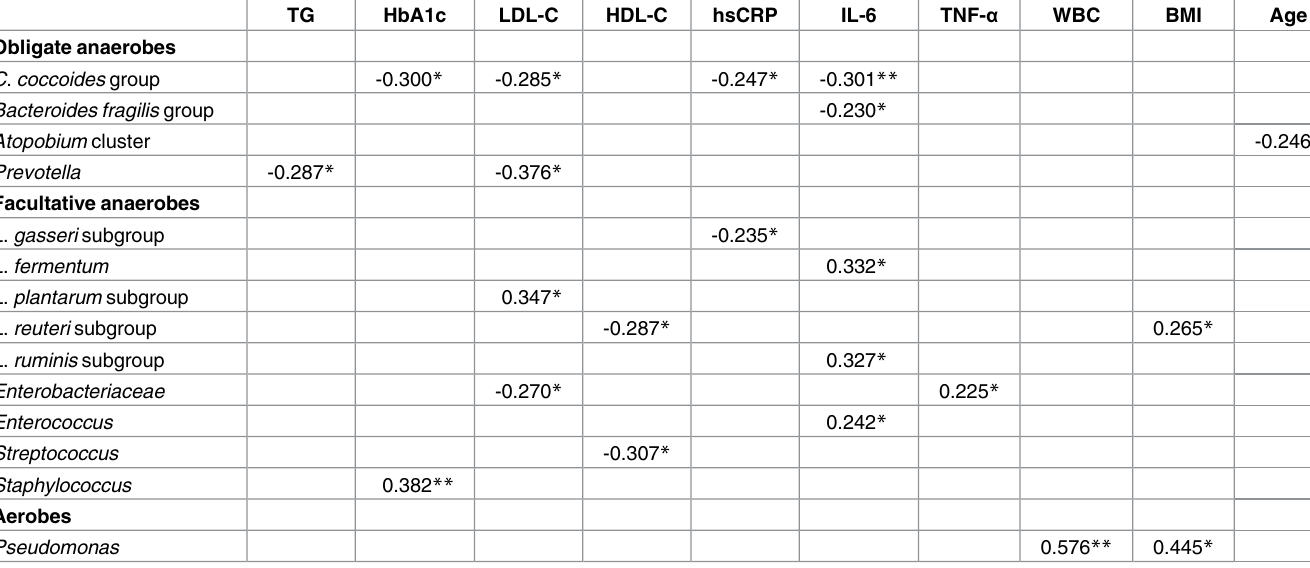
Table 4. Significant correlations between bacterial counts and bioclinical markers,as represented by Pearson’s correlation coefficient r